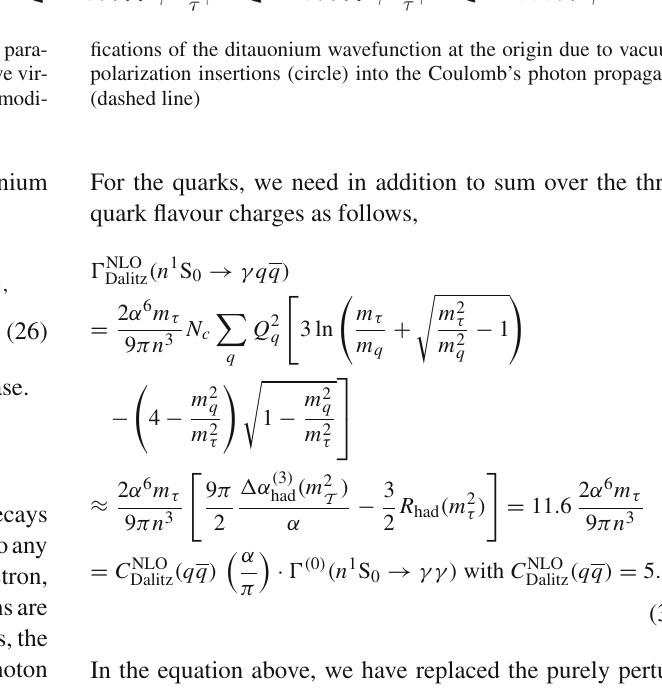
fications of the ditauonium wavefunction at the origin due to vacuum polarization insertions (circle) into the Coulomb’s photon propagator (dashed